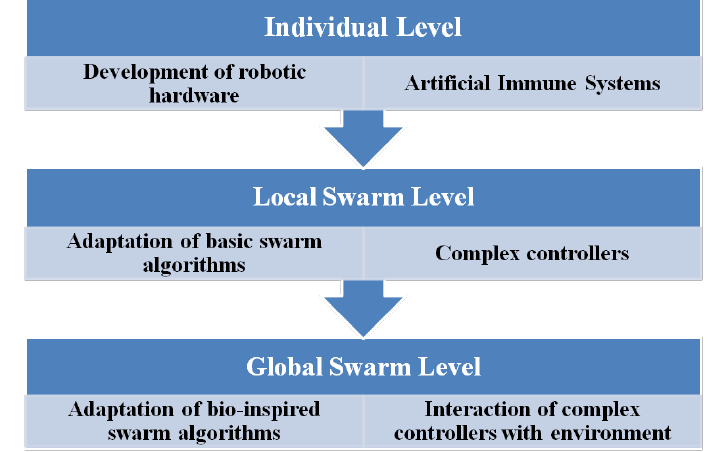
Figure 12. The whole picture of CoCoRo conceptualization, as described in [51].